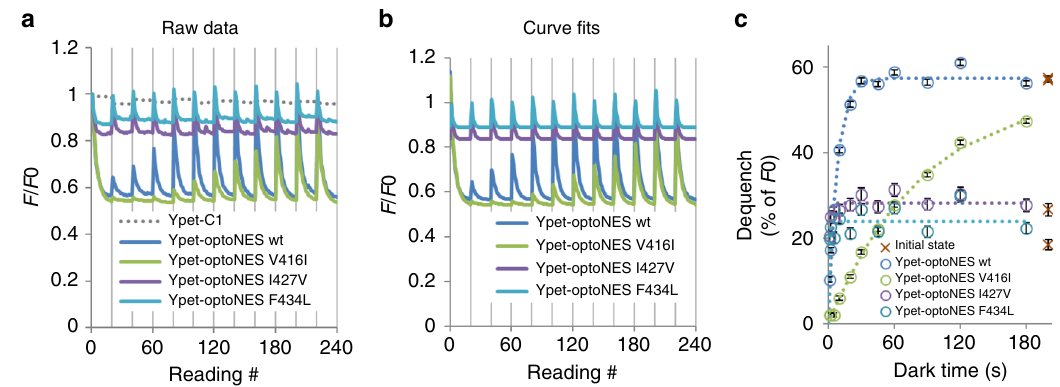
Fig. 8 RET allows mutational relaxation time optimisation to be monitored in situ. a Raw (vector-corrected) fl uorescence quench-recovery cycles captured from intact living HEK293 cells using the protocol used in Figs. 2 – 6 for quantitation of LOV2 switching and relaxation of optoNES constructs with wild-type LOV2 or photocycle mutants V416I, I427V and F434L. These are tagged with Ypet because the LOV2 FRET responses are larger and clearer. The dotted line shows the changes in the Ypet vector that does not contain LOV2, which is used to correct all traces. Data are means from n = 3 wells. b Curve- fi ts of vector-normalised quench-recovery data from a are shown. Curve fi tting is performed as described in the methods and provides activation time constants and dark dequench values plotted in c . c Relaxation time constants are estimated by exponential fi ts of the % of dequench values from b , and best- fi t values (±S.E., n = 3 wells) plotted against dark time preceding the dequench for each construct. The red crosses represent the initial dequench value of the fi rst measurement (taken as representing the dark state because the cells had not previously been exposed to light). Averaged parameters based on the experiments in parts a – c are listed in Table 1B. Relaxation time constants for the fast photocycle mutants I427V and F424L are 10 – 20 times shorter than the wild-type and V416I is about 10× longer. Relaxation is a consistent 10 – 15-fold faster than has been reported under cell-free conditions 3,23 . The extents of activation of the fast relaxing mutants are low, because of the considerable concurrent relaxation taking place during the activation conditions used. For the same reason apparent activation sensitivity and maximum dequench change inversely with relaxation rate. This is expected because a slower relaxation allows a more complete activation during the illumination phases while faster relaxation counteracts apparent activation and reduces the possible level of dequench at limiting photon fl ux. Source data are provided as a Source Data fi